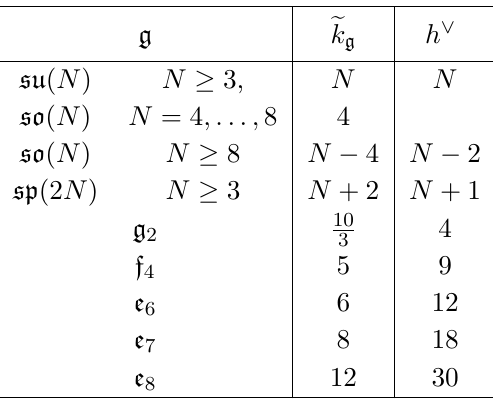
Table 2 . Values of e k g and h ∨ appearing in the unitarity constraints. Algebras not appearing in this table do not have any bounds on k g